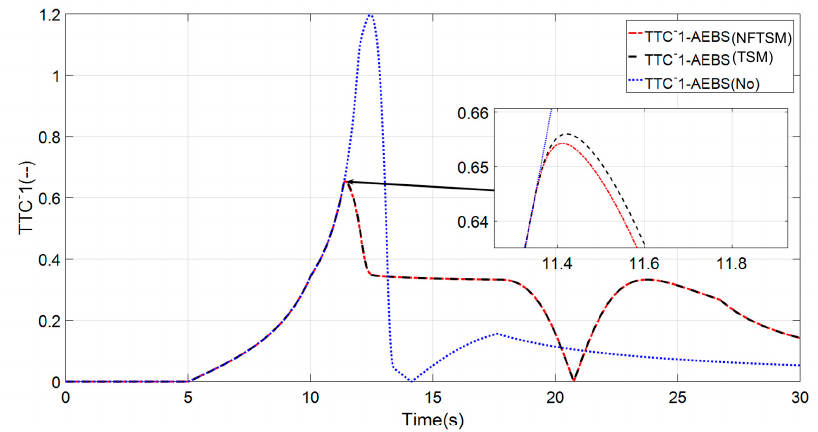
Figure 10. Comparison of TTC − 1 .